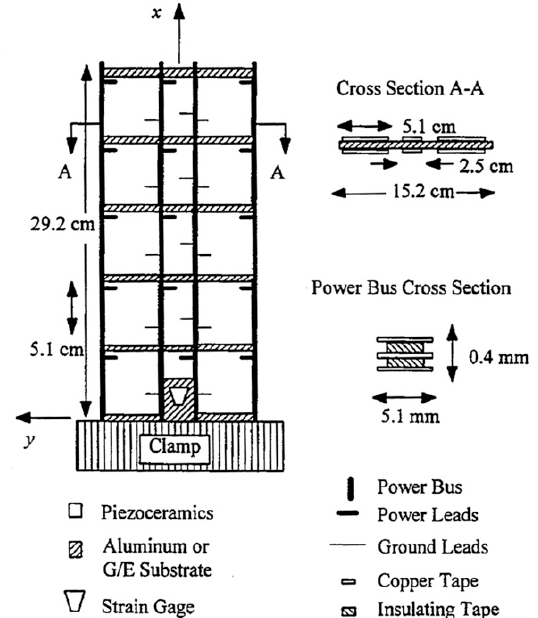
Figure 1. Schematic of the first twist-active piezoelectric aerodynamic plate.